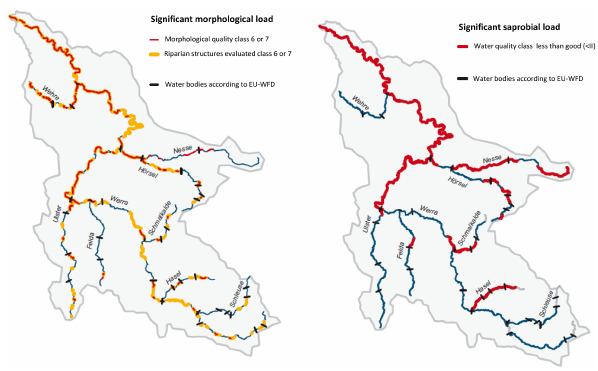
Figure 1. Significant morphological alterations (left) and signifi- cant saprobial load (right), indicating priority areas for measures (changed from Dietrich and Schumann,